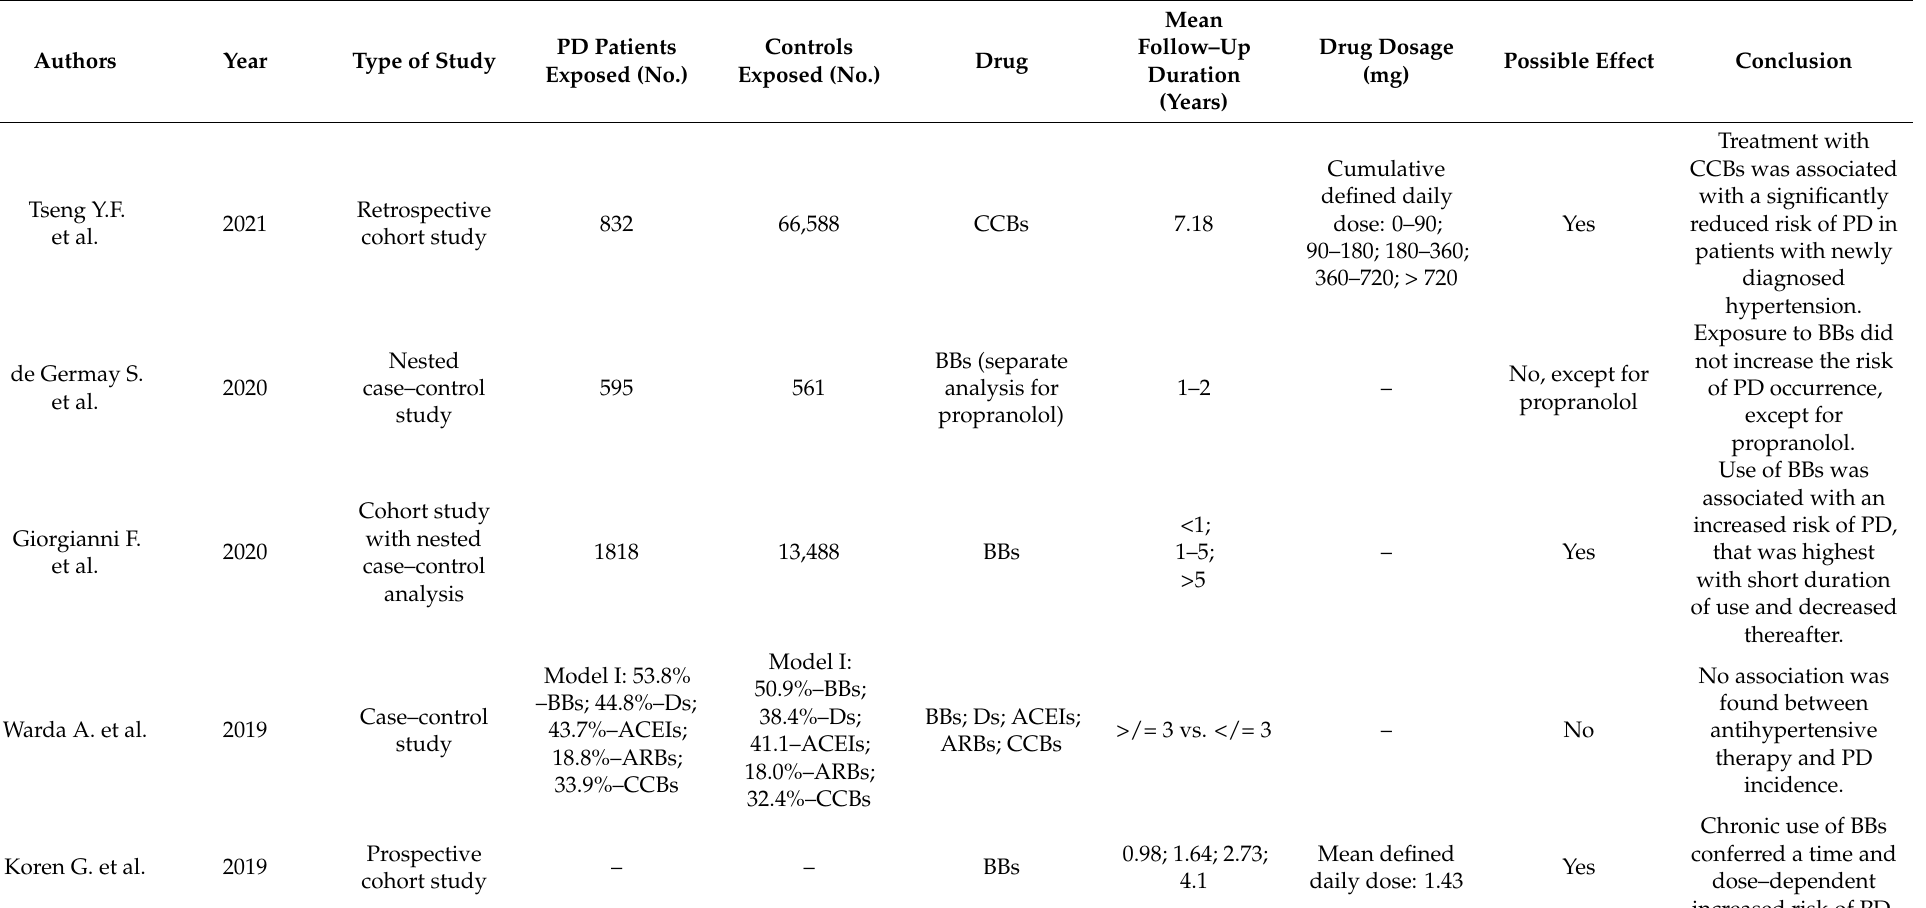
Table 1. Neuroprotective effect of antihypertensive drugs in